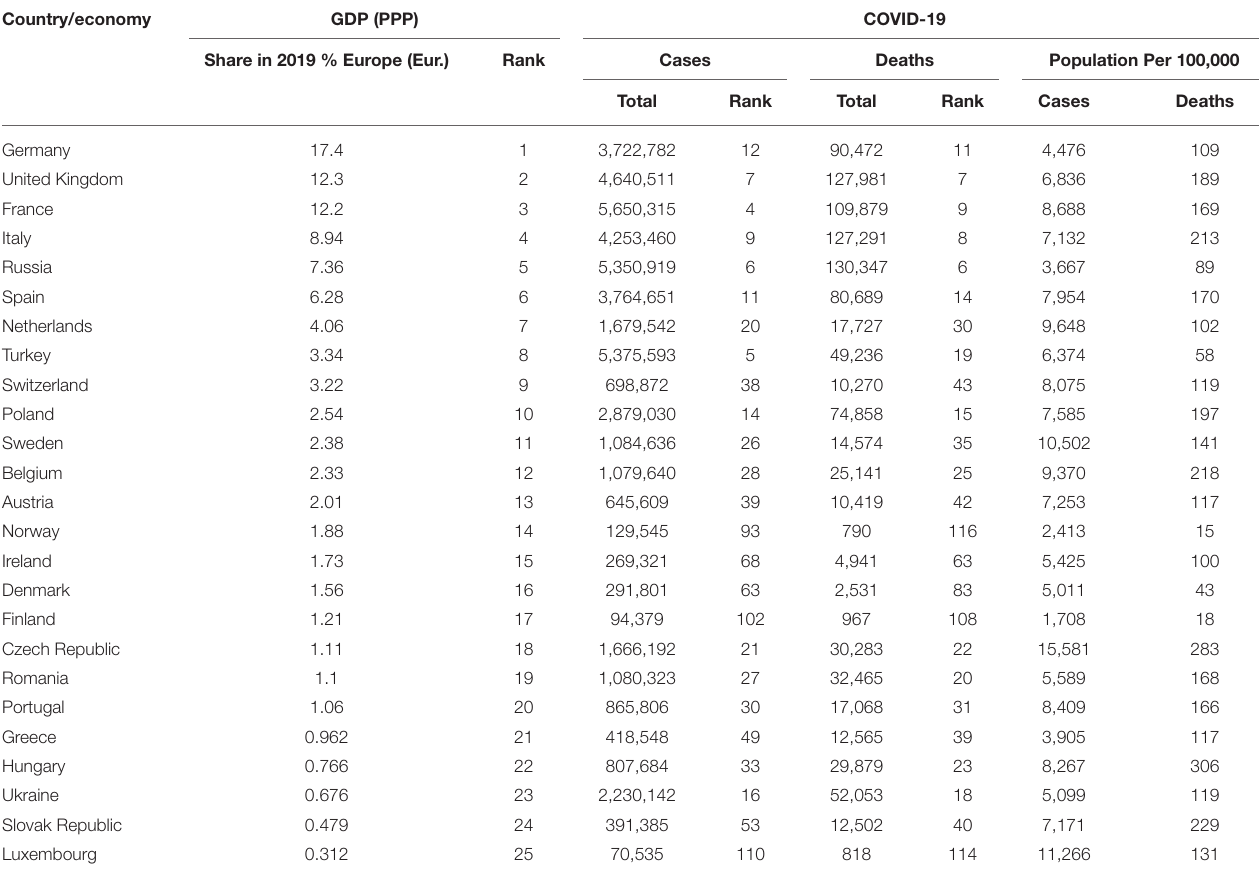
TABLE 1 | Ranking of the GDP and the situation of Covid-19 in European states. Country/economy GDP (PPP) COVID-19 Share in 2019 % Europe (Eur.) Rank Cases Deaths Population Per 100,000 Total Rank Total Rank Cases